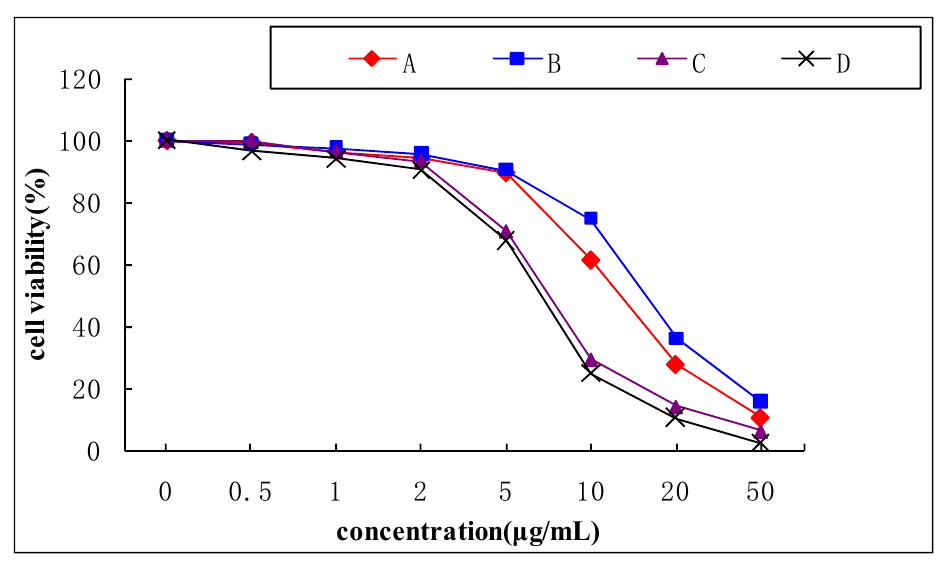
Figure 5. Cytotoxicity effect of aporphine alkaloids on 3T3-L1 cells. A: 2-hydroxy-1-